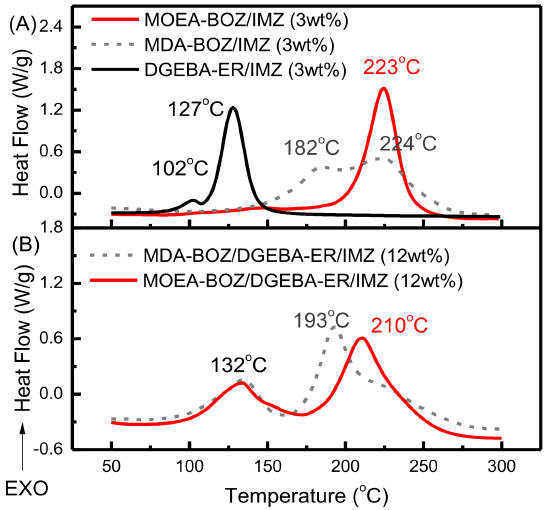
Figure 3. The DSC exothermal curves of MDA-BOZ, MOEA-BOZ, DGEBA-ER and their blends (7:3) with